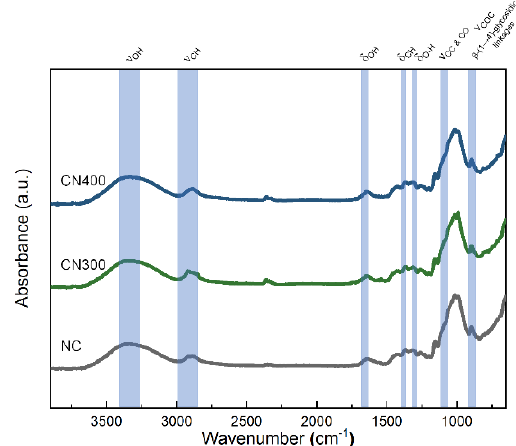
Figure 7. FT − IR spectra of NC, CN300, and CN400 in the range of 650–4000 cm − 1 .